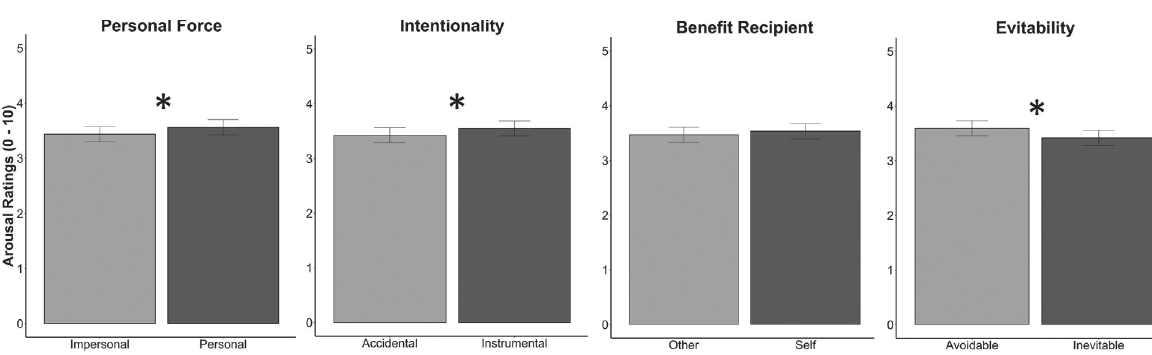
Figure 1. Arousal ratings distribution per conceptual factors. Error bars represent CI of LMM model. Significant differences ( P < 0.05) are indicated via *.